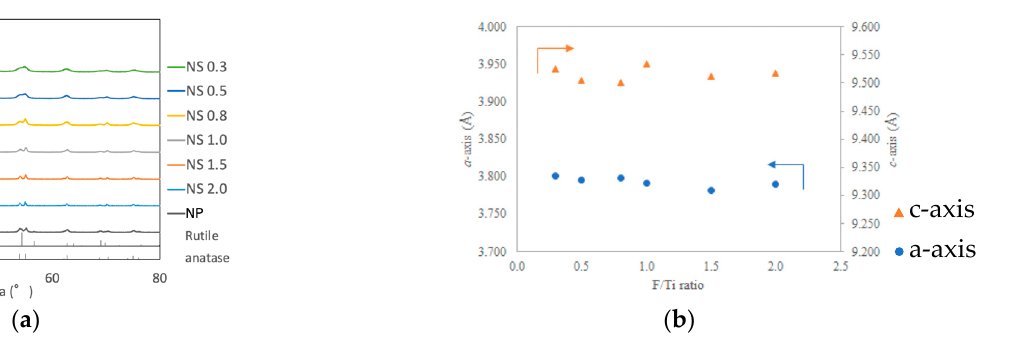
Figure 1. Characterization of TiO 2 nanosheets. ( a ) XRD patterns of TiO 2 NS0.3, NS0.5, NS0.8, NS1.0, NS1.5, NS2.0, and TiO 2 nanoparticles (NPs). ( b ) Lattice parameters of TiO 2 nanosheet.